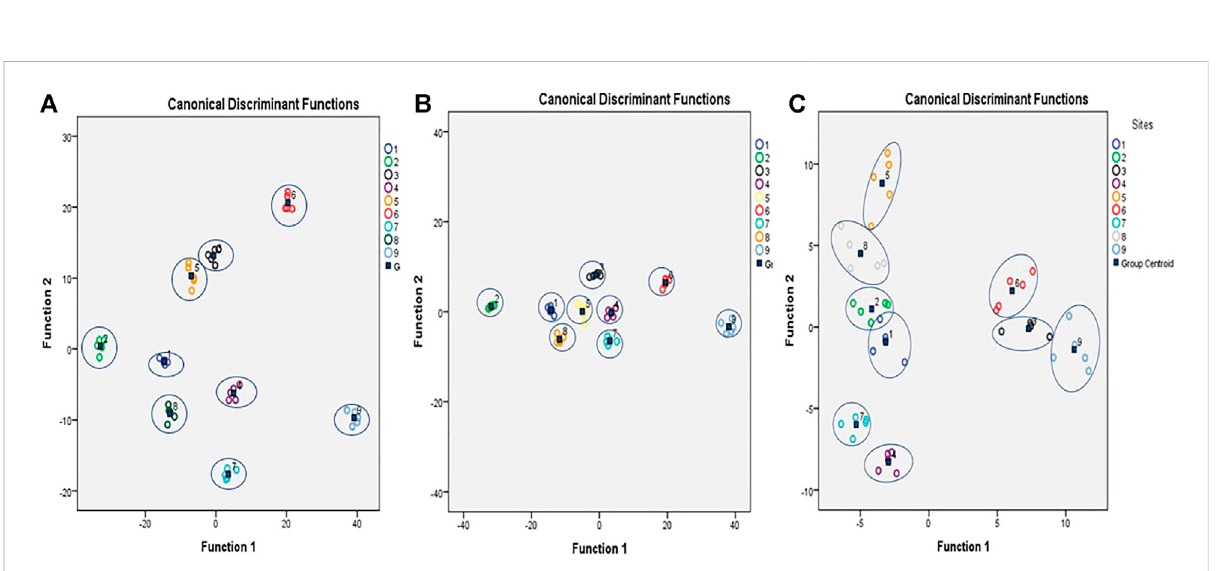
FIGURE 4 Discriminant function analysis of OS and AD parameters in tissues S. serrata as a function of season and zonation. Groups were formed by the x -axisand y -axis.Distinctgroupdiscriminationwasobserved,whichwasdividedintoninegroupswithoutanyoverlappingamongdifferentgroups.A clear discrimination was observed in all nine groups when (A) small AD, (B) enzymatic AD, and (C) All AD and OS parameters as a function of season and location were taken